Question: Name the type of graph shown.
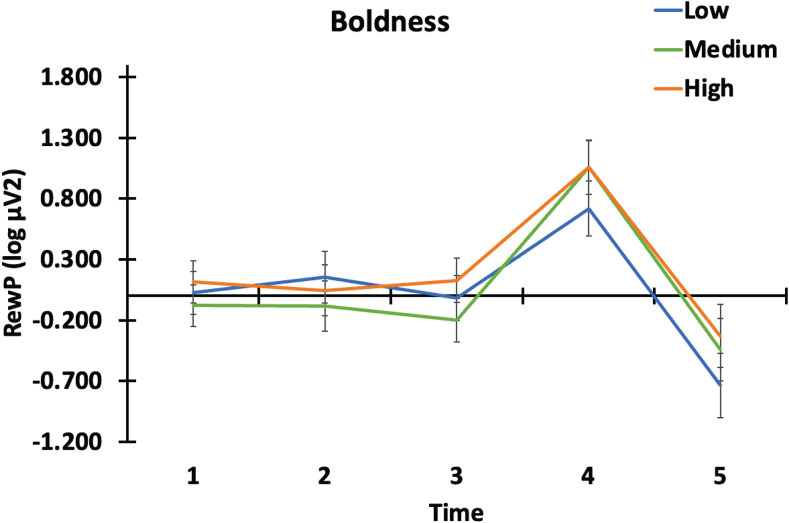
Answer: bar